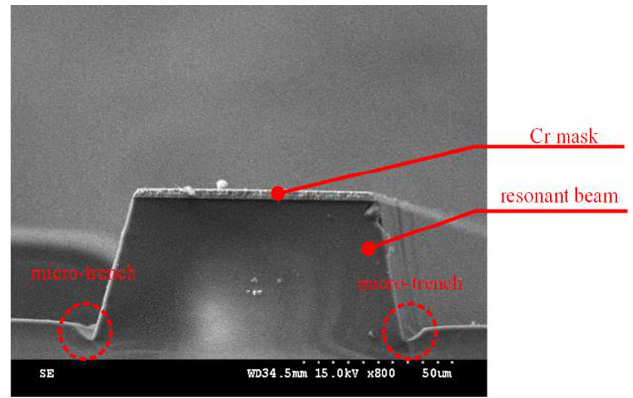
Figure 4. A micro-trench at the position between the sidewall and the bottom surface. Micromachines 2020 , 11 , x FOR PEER REVIEW